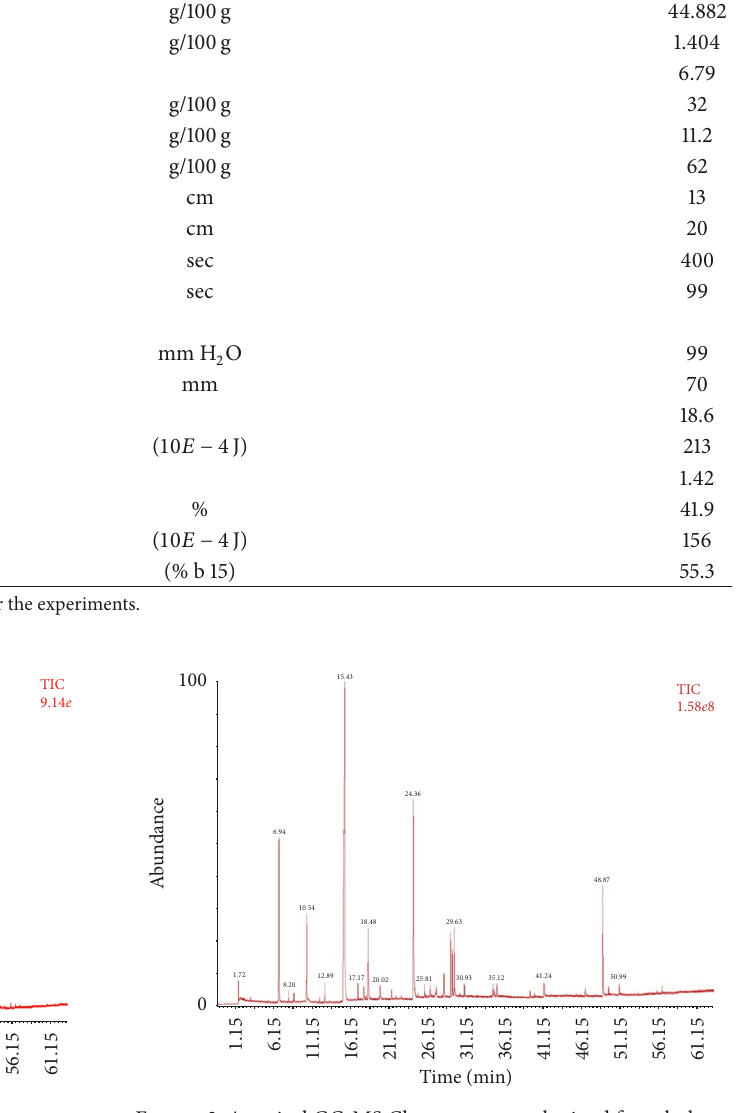
Figure 2: A typical GC-MS Chromatogram obtained from Durum wheat.